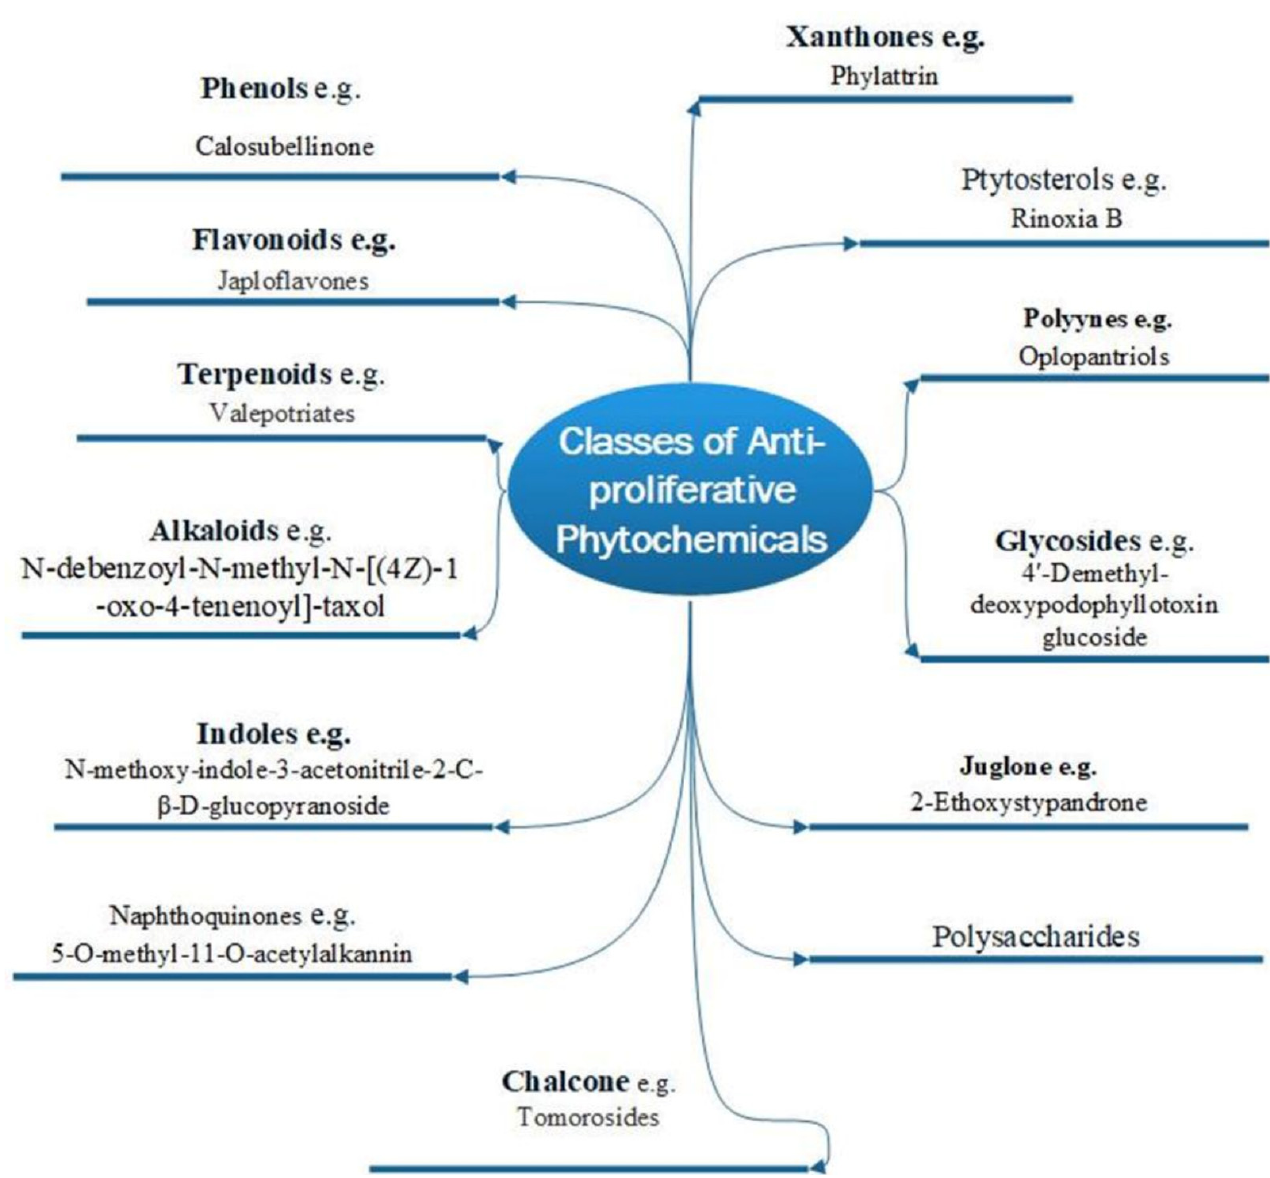
Figure 1. Various phytochemical classes with examples of new members.